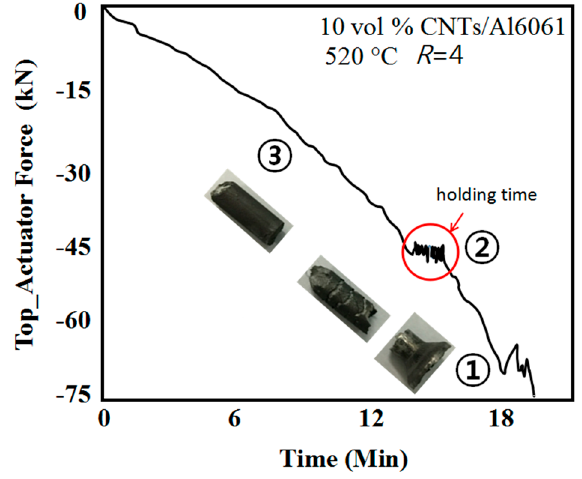
Figure 11. Top actuator force-time in the extrusion process.